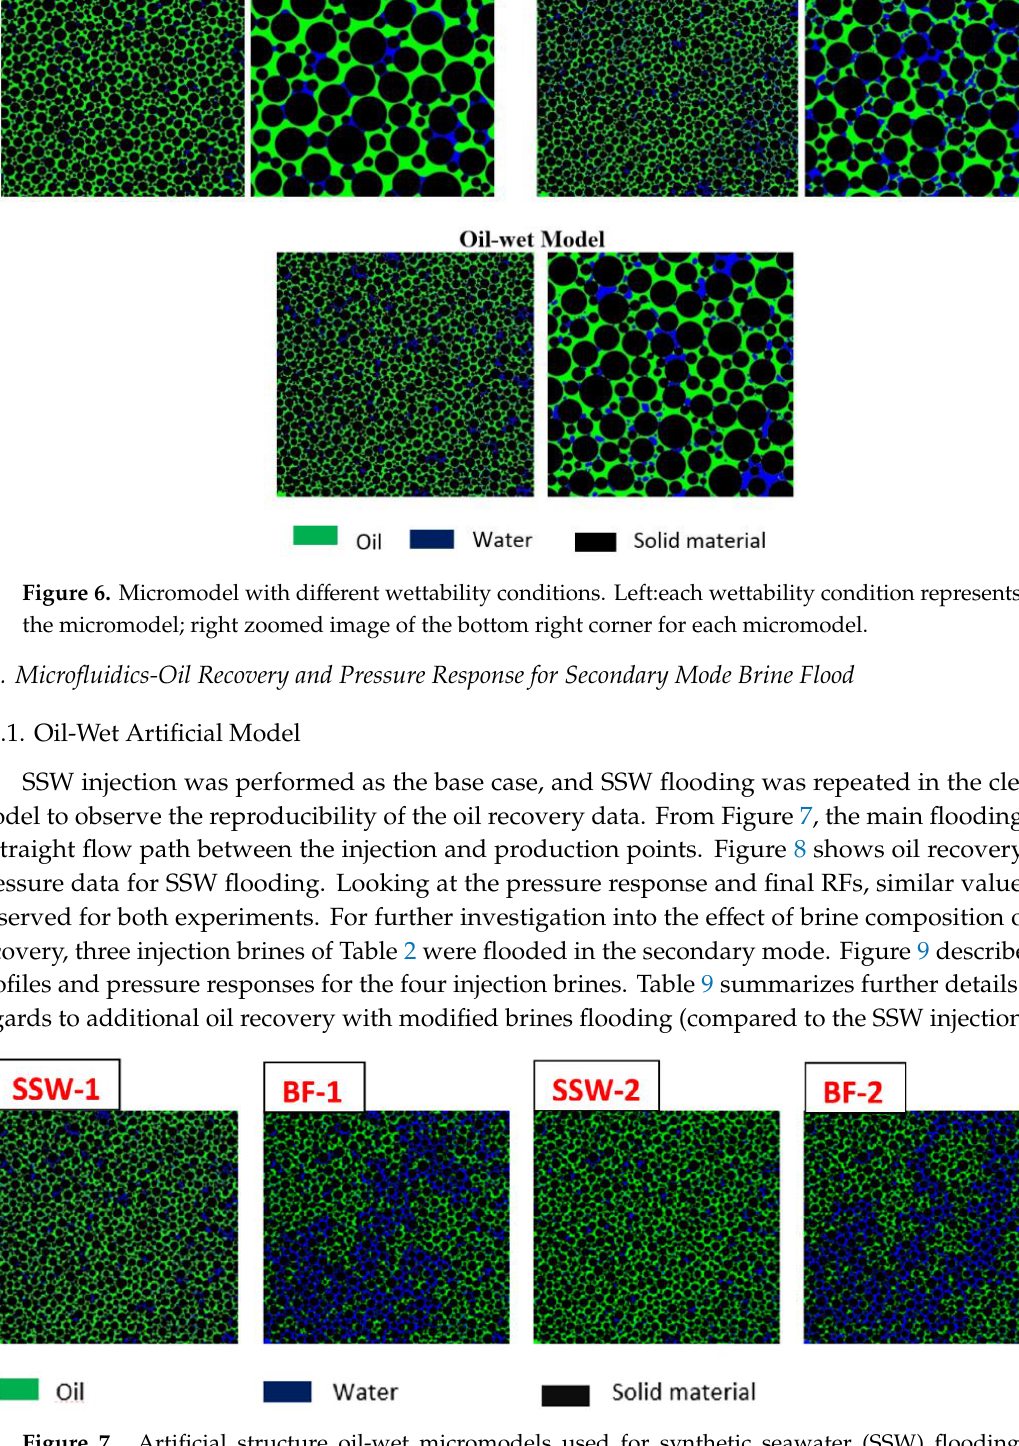
Figure 7. Artificial structure oil-wet micromodels used for synthetic seawater (SSW) flooding. SSW-1 / SSW-2 represents the oil initialization, while BF-1 / BF-2 represents after 10 PV injected brine. Table 9. Summary of artificial structure oil-wet micromodel with initial oil saturation, connate water saturation and final oil recovery factor.